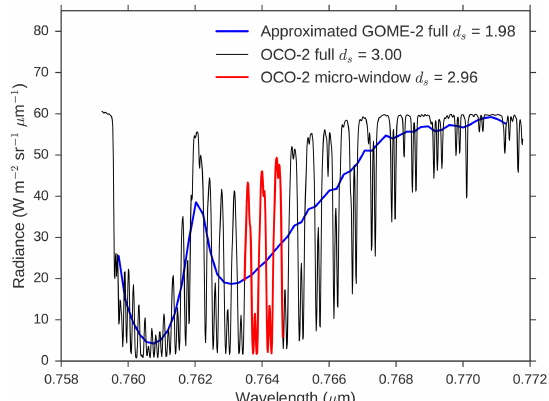
Figure 6. Example simulated cloudy scene A-band spectrum, for a τ = 10, P top = 850hPa cloud in a tropical atmosphere with a solar zenith angle of 45 ◦ . The black line shows the full OCO-2 simulated spectrum, the blue line is the black line resampled using approx- imate GOME-2 instrument line shapes and the red line is the se- lected 75-channel micro-window for OCO-2 cloud retrievals. The legend also reports the d s for each spectrum with the GOME-2 in- strumental uncertainty based on an SNR of 100 as in previous work (Schuessler et al.,